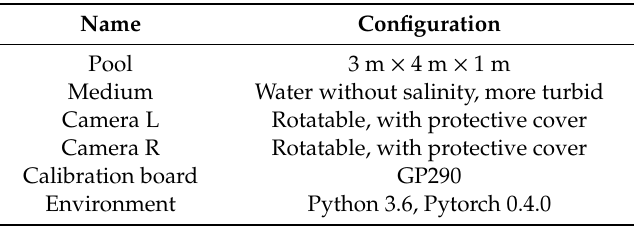
Figure 4. UVNets: an underwater vision target detection and tracking system.